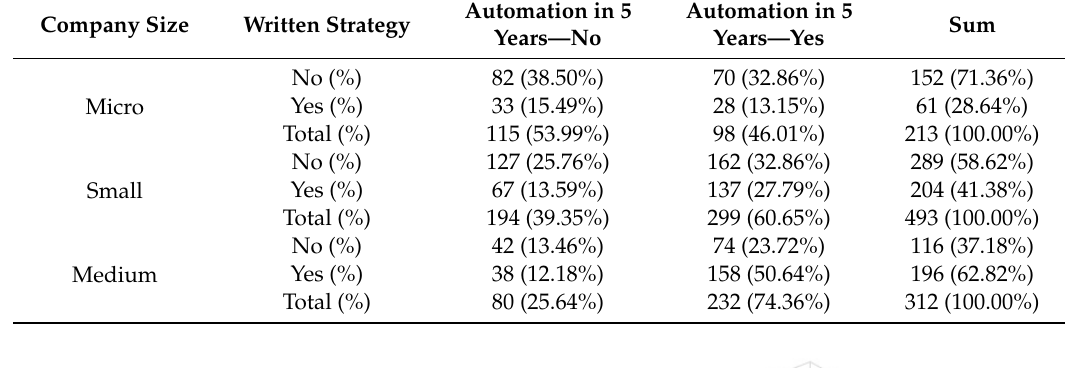
Table 2. Frequency comparison in SMEs.